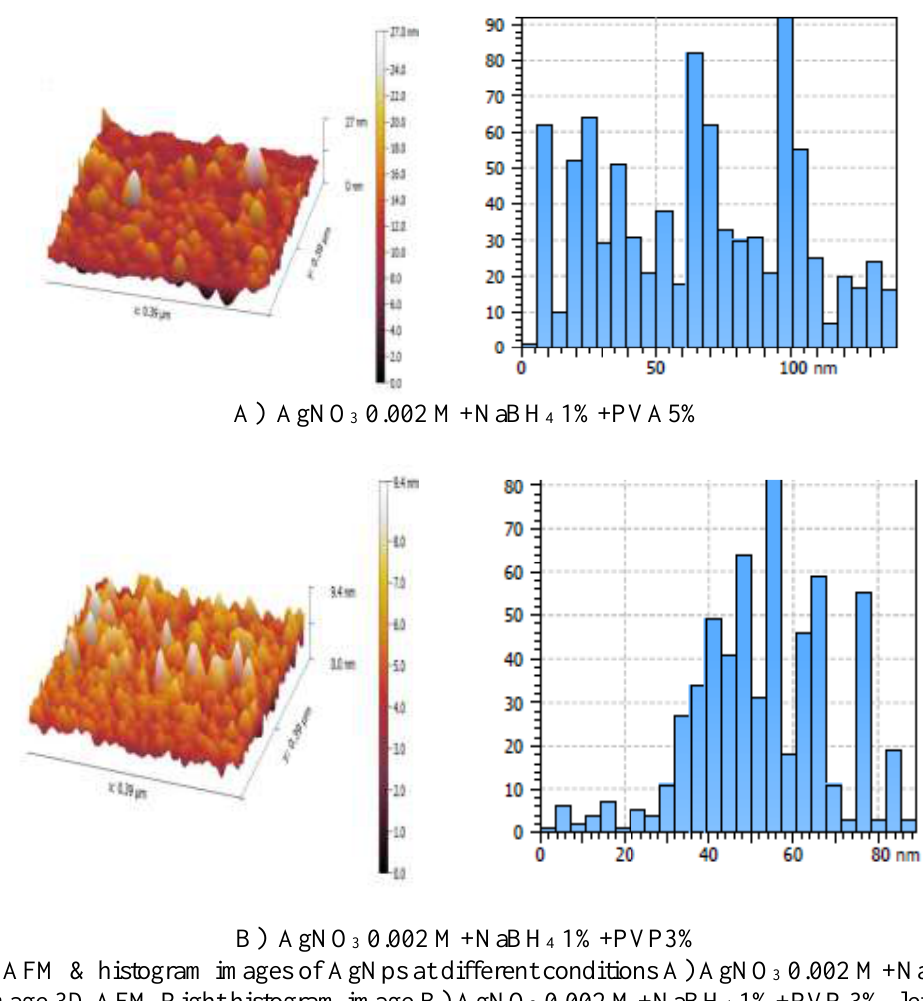
Figure 6: 3D AFM & histogram images of AgNps at different conditions A) AgNO 3 0.002 M+NaBH 4 1%+PVA 5%, left image 3D AFM Right histogram image B) AgNO 3 0.002 M+NaBH 4 1%+PVP 3%, left image 3D AFM Right histogram